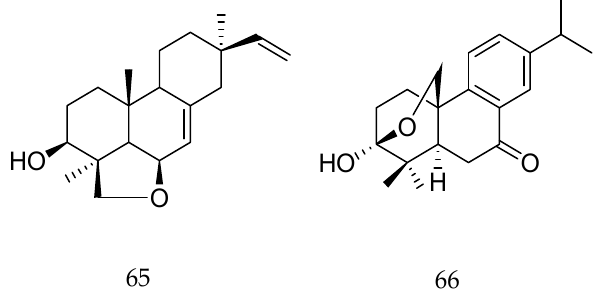
Figure 27. Chemical structures of diterpenes 65 and 66 [112].